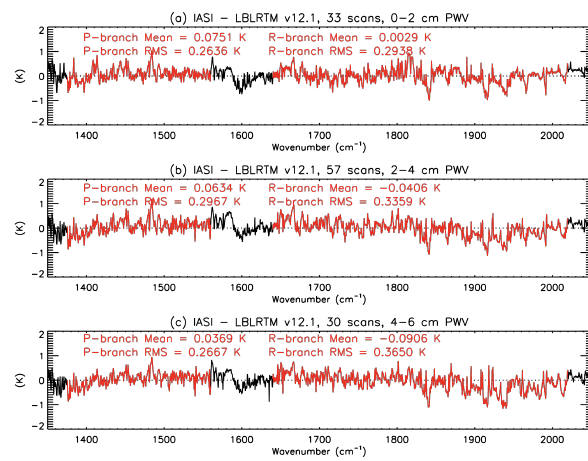
Fig. 15. Mean final (a posteriori) brightness temperature residuals in the ν 2 band of H 2 O using LBLRTM v12.1 as in Fig. 12b, but only for profiles with (a) 0 to 2cm, (b) 2 to 4cm, and (c) 4 to 6cm of precipitable water vapor.